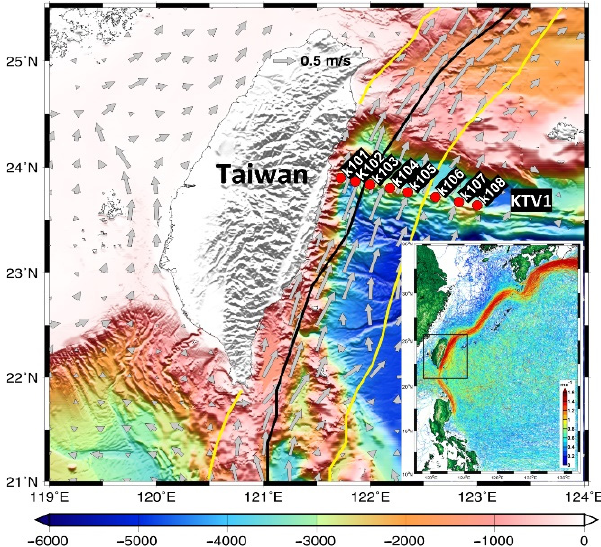
Figure 1. Sampling stations (K101–K108) along the KTV1 transect of the Kuroshio east of Taiwan. The climatological current velocity (gray arrows) at a depth of 30 m was computed from the historical ADCP dataset available from Taiwan’s Ocean Data Bank. The bold black line indicates the maximum velocity axis at 15 m depth obtained from the surface drifter data. The solid yellow line indicates the 0.2 m s − 1 isotach at 30 m depth obtained from the historical ADCP dataset [28]. The path of the Kuroshio with velocity >1 m s − 1 is indicated by surface drifter trajectories and speeds (data available at http://www.coriolis.eu.org/Data-Products/Data-Delivery/Data-selection; accessed on 27 February 2018) in the lower right inset, where the black dotted rectangle marks the map area. (Modified from Figure 1 of Chen et al.